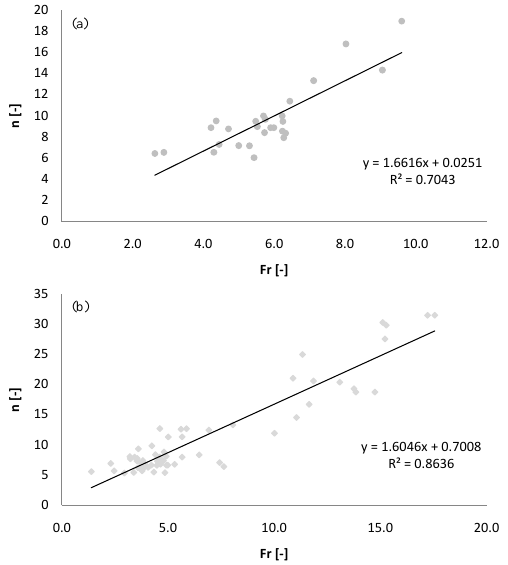
Figure 8. Linear correlation between filling ratio, n and Froude number, Fr for dataset obtained respectively by flume inclination equal to 30 ◦ (a) and 35 ◦ (b)